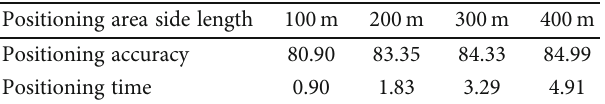
Table 2: Simulation results of tertiary positioning area size based on K -nearest neighbor method.